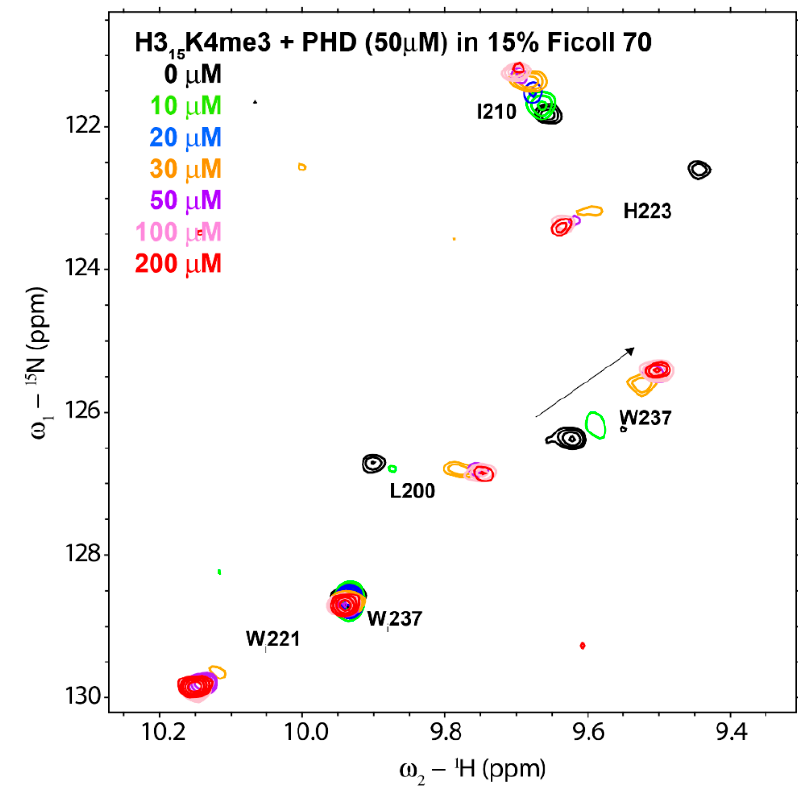
Figure 2. Superimposition of a region of 1 H- 15 N HSQC spectra of ING4-PHD after addition of di ff erent amounts of H3K4me3 peptide, indicated with di ff erent colors. The labels adjacent to the signals indicate the PHD residue (“W i ” stands for the tryptophan indole NH signals). Conditions: 50 µ M PHD in 20 mM sodium phosphate pH 6.5, 50 mM NaCl, 1 mM perdeuterated dithiothreitol, 15% Ficoll 70, 5% ◦ 2 H 2 O, and 0.01% NaN 3 , at 25